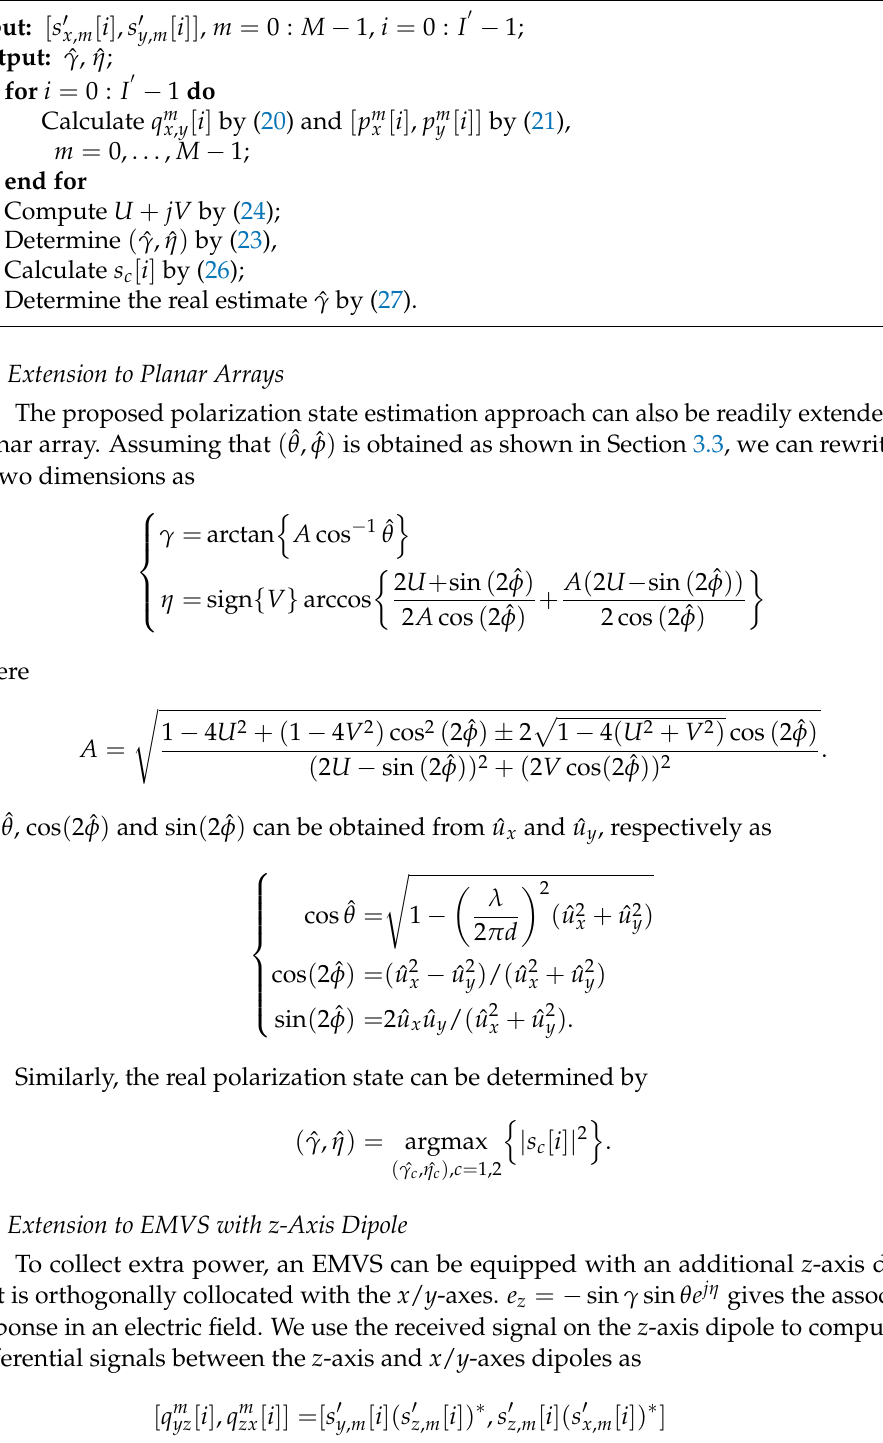
Algorithm 2 Enhanced Polarization